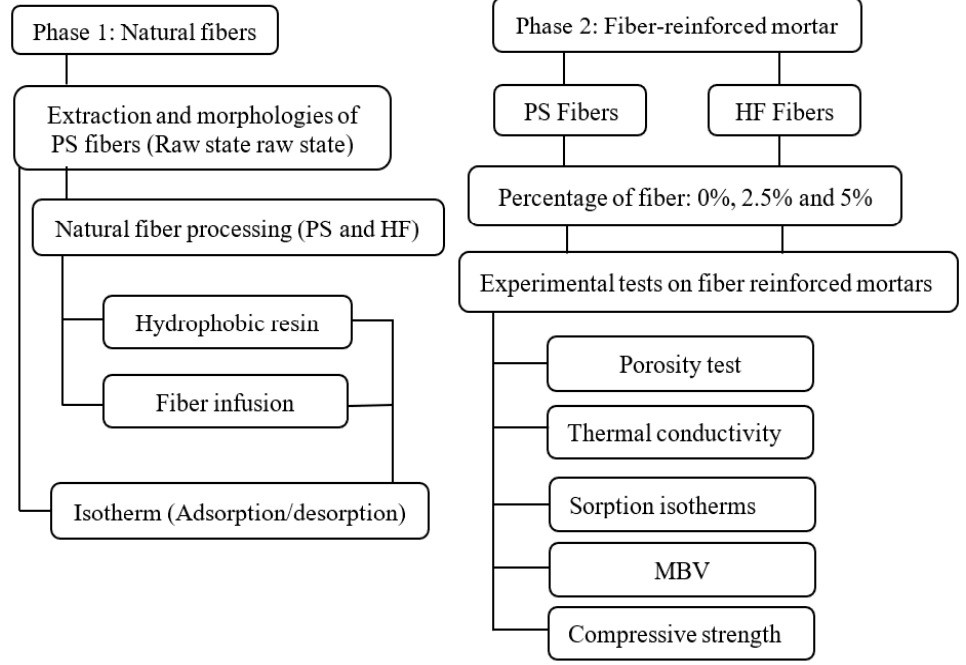
Figure 1. Summary of the experimental program.